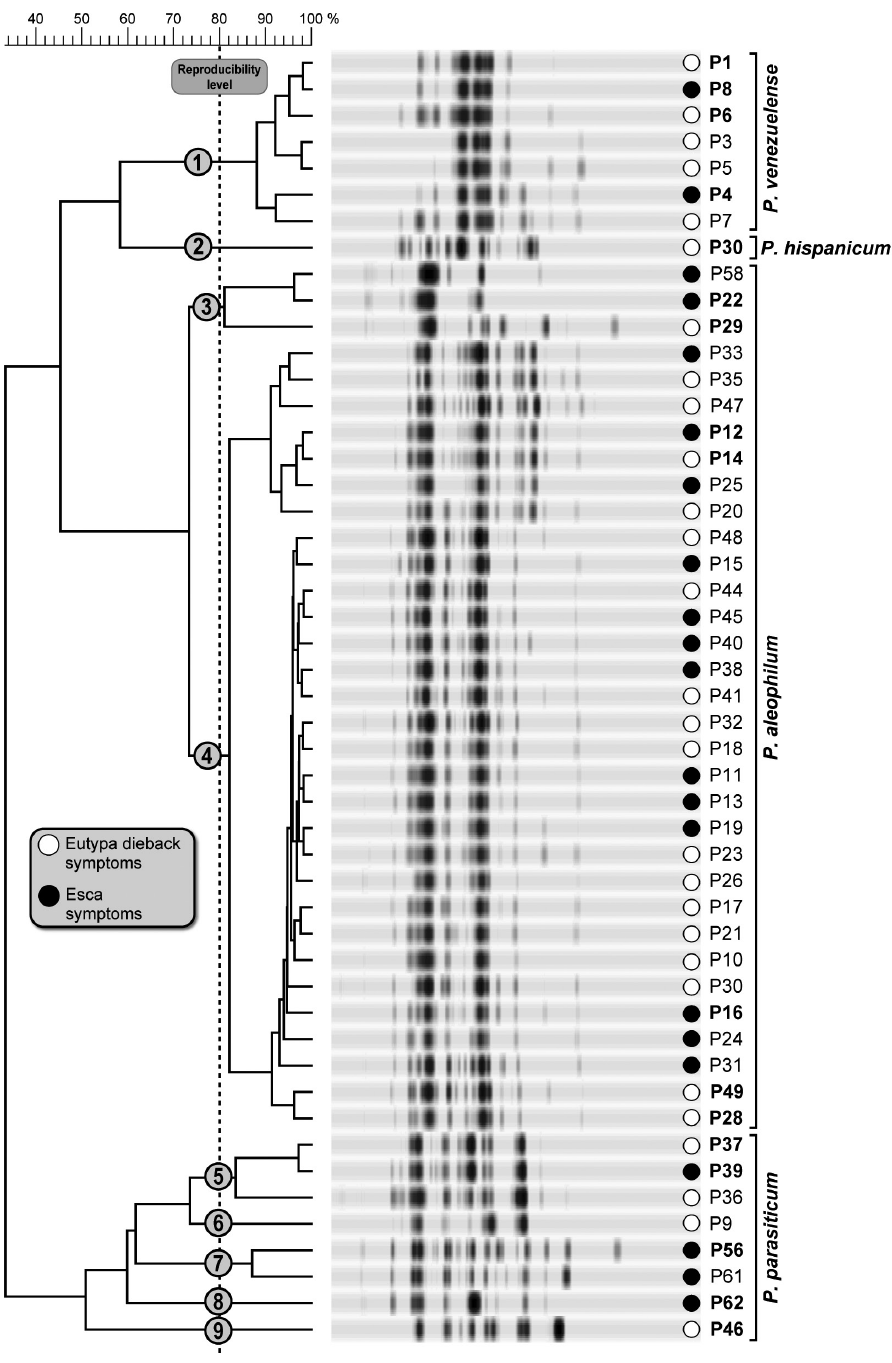
Figure 1. Consensus dendrogram from MSP-PCR profiles obtained with primer M13. The vertical dashed line cor - responds to the reproducibility level (80%) from which nine groups of isolates are inferred (indicated by numbered circles). In each group, the isolates highlighted in boldface were selected for phylogenetic analysis. All fingerprints were grouped by similarity using the Pearson correlation coefficient and UPGMA. Isolates obtained in this study from vines with eutypa dieback or esca symptoms are indicated by white and black circles